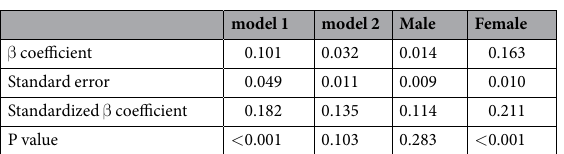
Table 3. Relationships between sleep quality and HbAlc in regression models at baseline. Model 1 was the unadjusted model. Model 2 adjusted for gender, age, educational level, family income, smoking, drinking, BMI, duration of diabetes, and the presence of anxiety and depressive symptoms. Male and Female: adjusted for age, educational level, family income, smoking, drinking, BMI, duration of diabetes, and the presence of anxiety and depressive